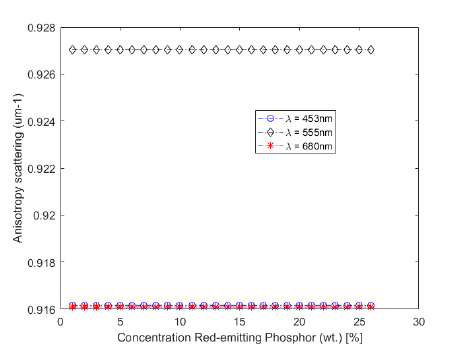
Fig. 3: Anisotropy scattering